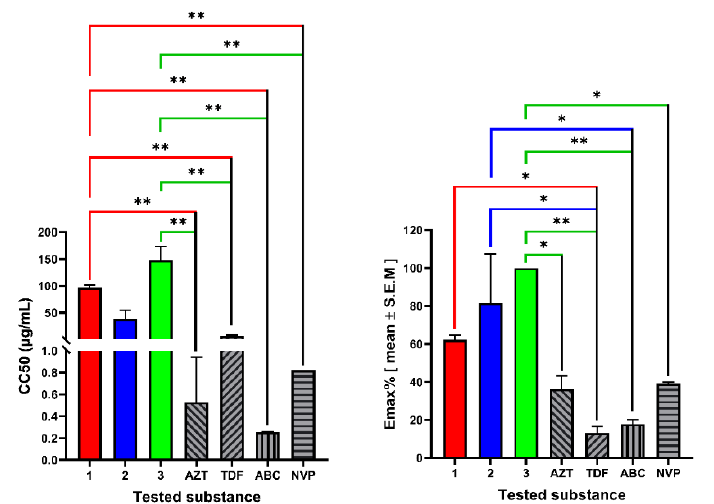
Figure 5. Cytotoxicity of ermiasolides from C. megalocarpus. The results are expressed as the mean of three independent experiments ± S.E.M. 1, ermiasolide A; 2, ermiasolide B; 3, ermiasolide C; AZT, zidovudine, ABC, abacavir, NVP, nevirapine; TDF, tenofovir; C, control; ns; not significant, * De- notes p value < 0.05, ** Denotes p value <0.01 Table 2. Cytotoxicity and anti-HIV-1 activities of ermiasolides from C. megalocarpus.